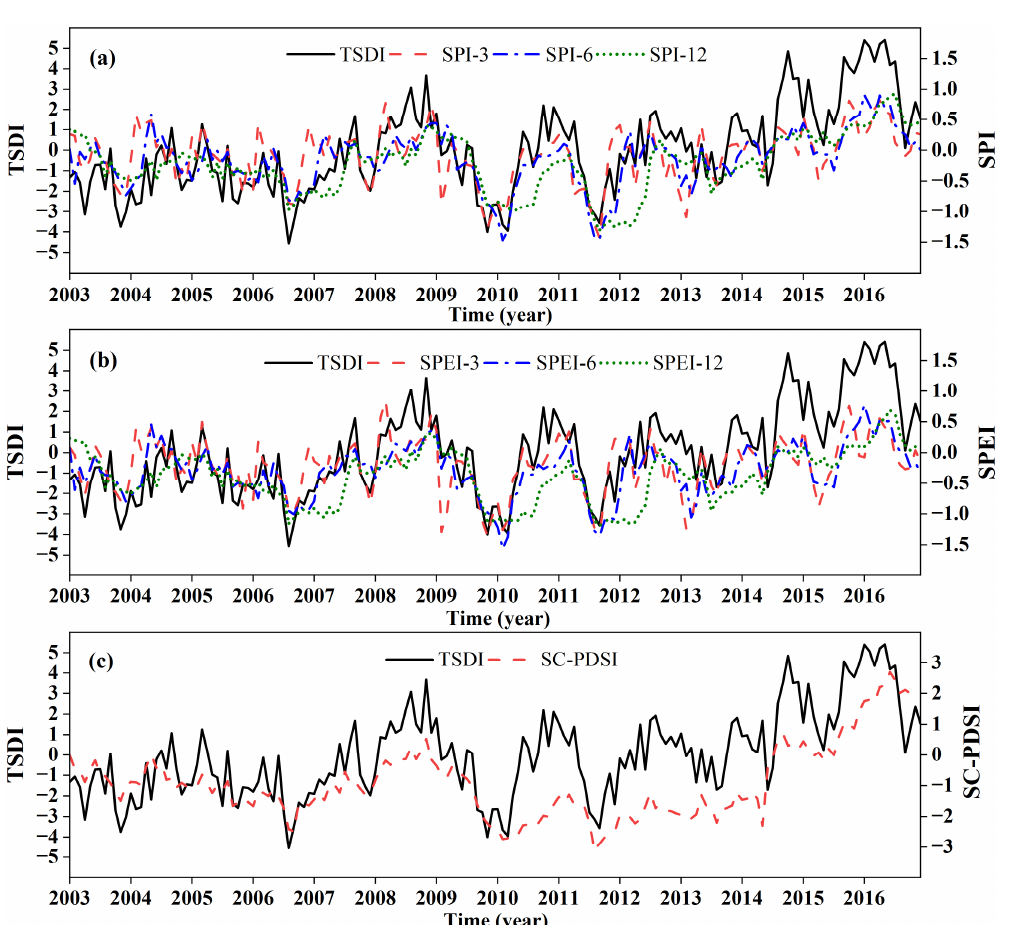
Figure 5. Comparison of the monthly GRACE-based TSDI with other drought indices: ( a ) SPI-3, SPI-6, SPI-12; ( b ) SPEI-3, SPEI-6, SPEI-12; ( c ) SC-PDSI.